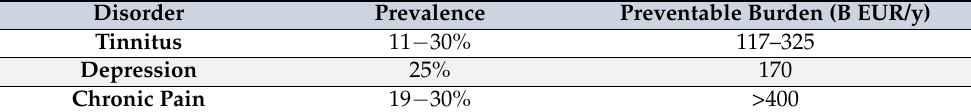
Table 1. Prevalence and financial burden of tinnitus, depression, and chronic pain as a proportion of the EU population with the approximate direct and indirect cost imposed on EU societies.